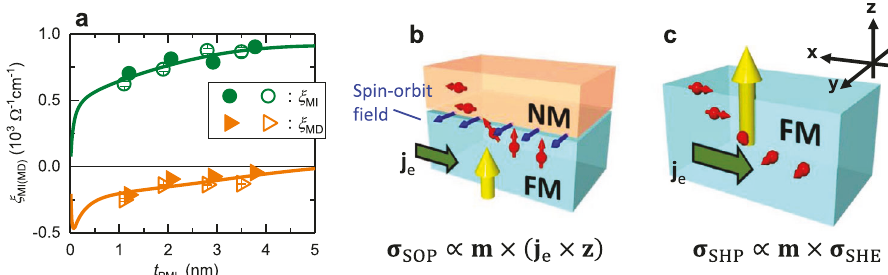
Fig. 3 Origin of charge-to-spin conversion in FM. a Dependence of ξ MI and ξ MD on PML thickness in Series A ( fi lled symbol) and B (open symbol) samples. Solid curve shows the fi tting results using theoretical formula. b , c Schematic of two generation mechanisms of σ MD . Yellow arrow indicates magnetization of FM ( m ) and red arrow is spin orientation of spin current. b Spin – orbit precession effect triggered by spin – orbit fi eld (blue arrow) at the interface ( σ SOP ). c Proposed spin-Hall precession effect within FM ( σ SHP